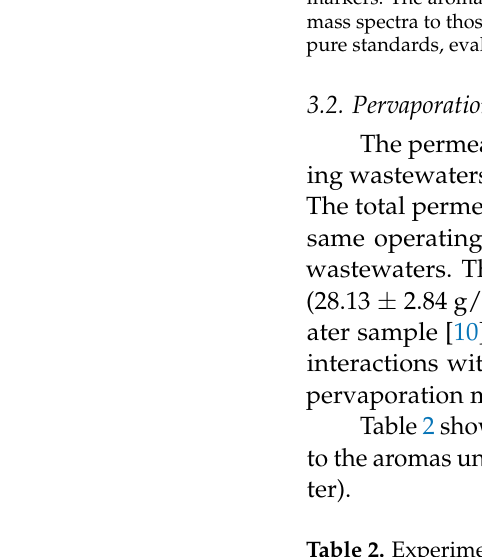
Table 2. Experimental parameters of pervaporation were performed with a downstream pressure of 1500 Pa, with real wastewater: aroma flowrate ( Ji ), permeability ( Li ), and selectivity of each aroma (against